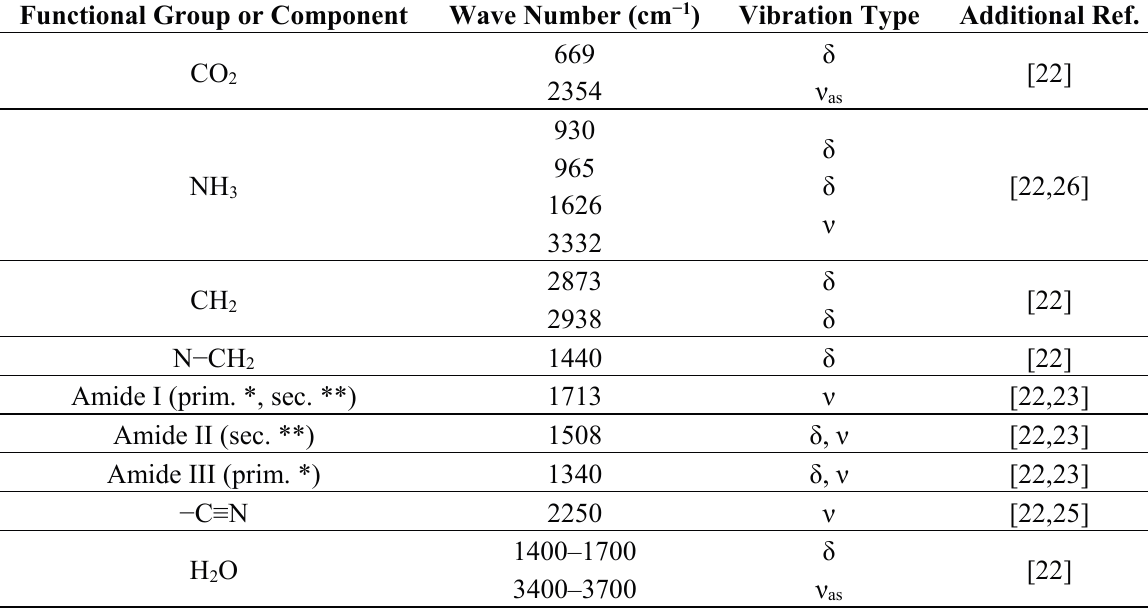
Figure 6. FTIR spectra of the gases evolved during the thermo-oxidative degradation of PA6 (—), PA6/GAS 5% (--) and PA6/GAS 2.5%/MPP 2.5% (···) at characteristic temperatures of degradation. Table 6. IR peak assignments for PA6 and PA6/AS 5% (* primary, ** secondary). Functional Group or